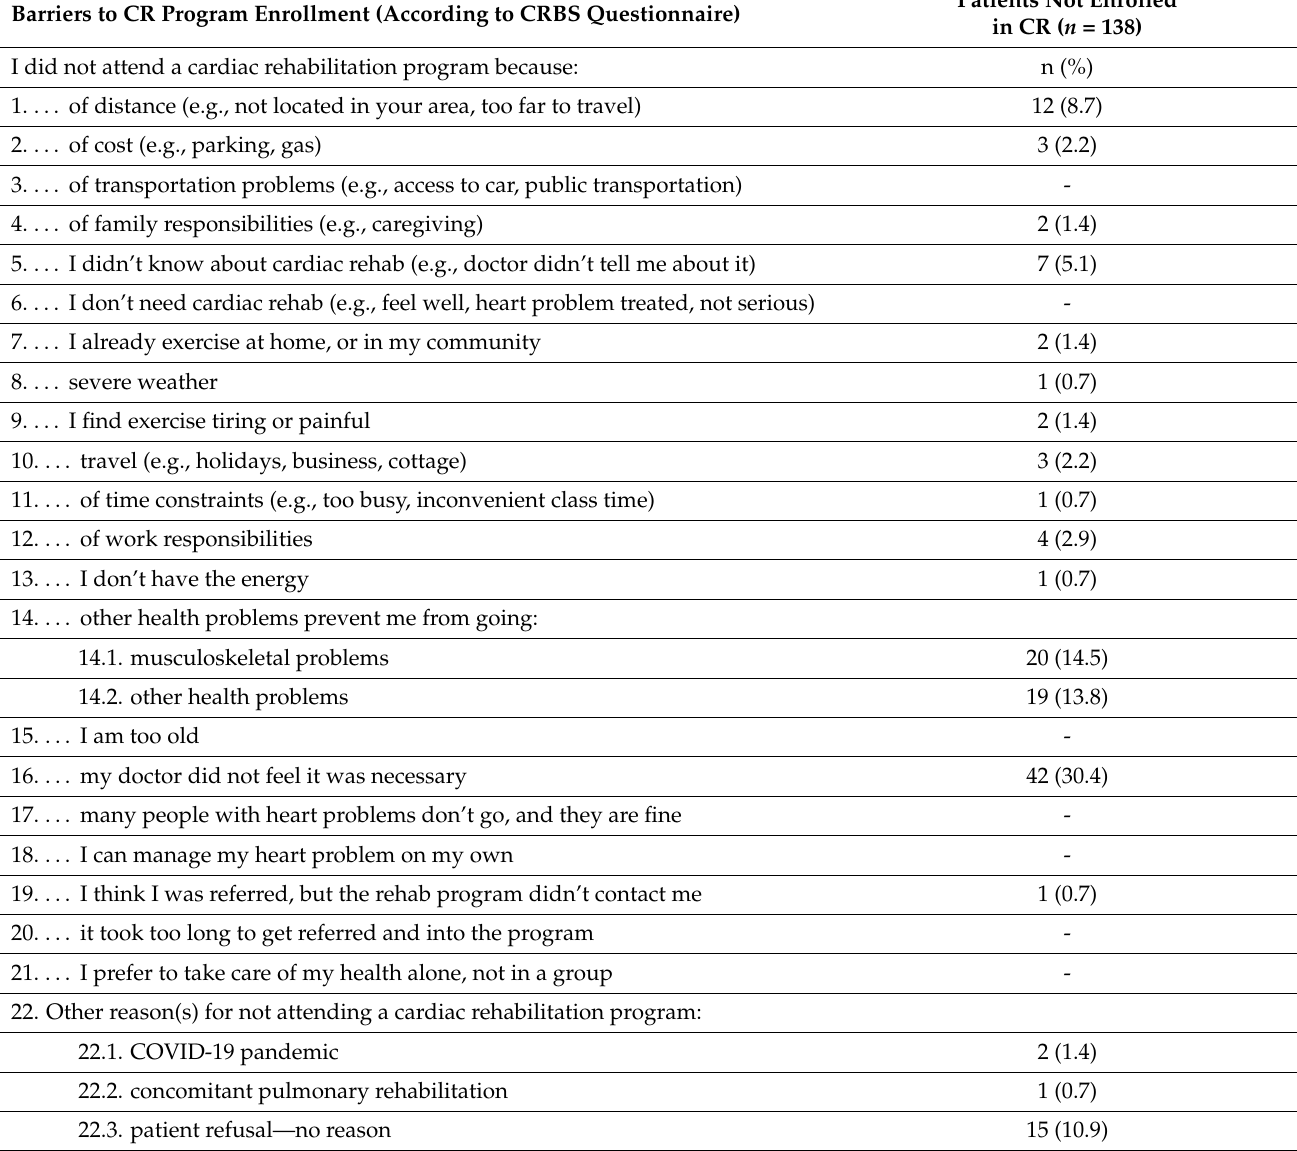
Table 6. Barriers to cardiac rehabilitation enrollment of patients with heart failure with reduced ejection fraction according to the Cardiac Rehabilitation Barriers Scale (CRBS) questionnaire.